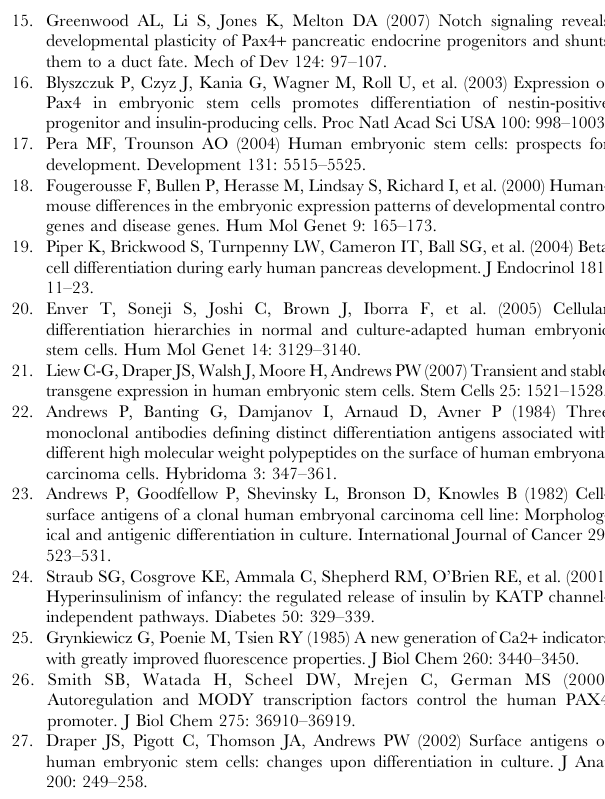
Table S1 Oligonucleotide primer sequences used for standard and quantitative PCR in this study. All primers were designed and tested by the authors unless otherwise indicated in Table S1. Primers produced PCR products migrating as single bands of the expected molecular size on agarose gel electrophoresis. PCR products were purified and sequenced to confirm product identity. Figure S1 Plasmid map of the vector used to transfect HESC. pCAG-PAX4 contains an internal ribosomal entry site (IRES), conferring bicistronic expression of PAX4 coding sequence (CDS; located at 207-1238 base pairs [bp] on Homo sapiens PAX4 mRNA, Gene Bank Accession Number NM_006193) and puromycin-resistance genes, under the control of the CAGG promoter coupled to a PyF101 mutant enhancer. Figure S2 Differentiation of H7 control and H7.Px4 EBs over a period of 21 days was associated with the expression of Foxa2, a marker of definitive endoderm which persists during pancreatic development. NeuroD1 was expressed earlier in the H7.Px4 EBs relative to controls. Genes encoding subunits of the ATP-sensitive K + channel (ABCC8 and KCNJ11) which are critical for depolarization-response coupling in b -cells were expressed at all time points in both H7.Px4 and controls. Gcg encoding glucagon gene was upregulated in 2/3 H7.Px4 clones during differentiation but was never detected in H7 control EBs. All data are typical of n =4 experiments on control H7 cells and EBs, and from n= 1 experiment from each of 3 independent H7.Px4 clones. M,